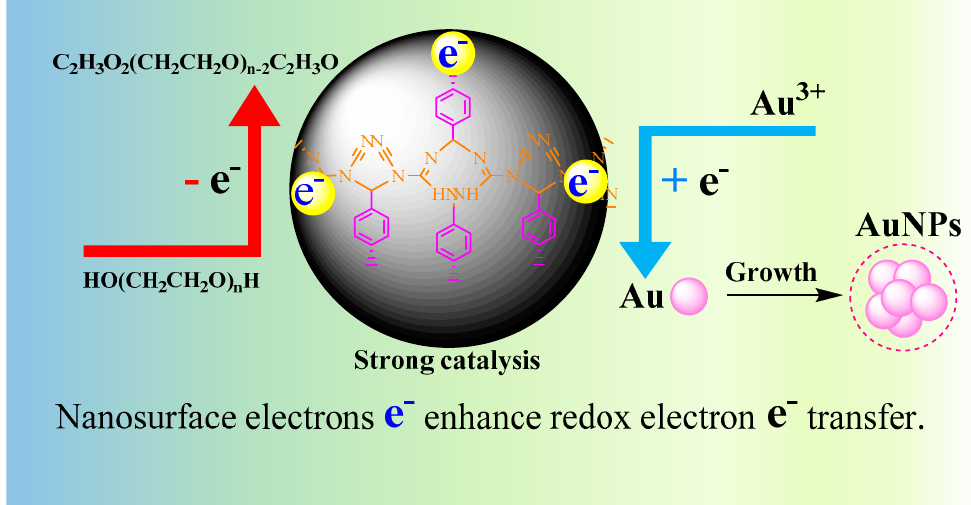
Figure 4. DdBd catalytic enhancement mechanism.